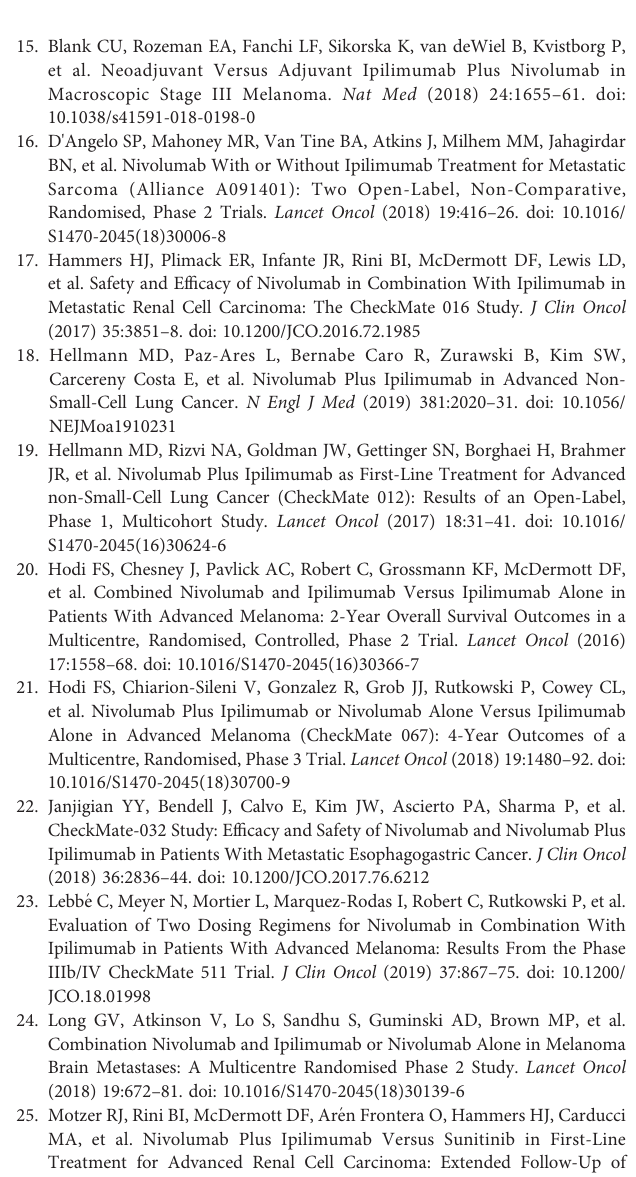
Supplementary Figure 1 | Forest plot of any adverse events in N1-I3 subgroup. Supplementary Figure 2 | Forest plot of grade 3 or higher adverse events in N1- I3 subgroup. Supplementary Figure 3 | Forest plot of any adverse events in N3-I1 subgroup. Supplementary Figure 4 | Forest plot of grade 3 or higher adverse events in N3- I1 subgroup. Supplementary Figure 5 | Forestplotoftreatment-relateddeathsinN1-I3subgroup.